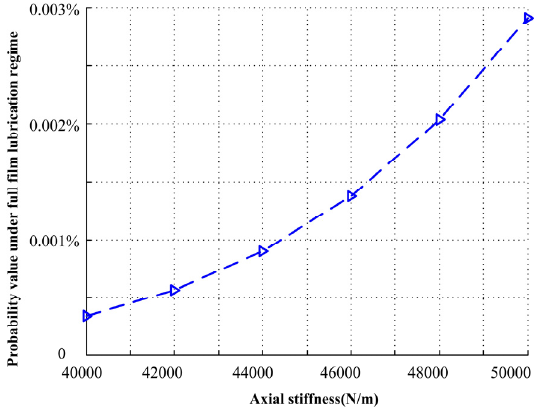
Figure 13. Probability value under different axial stiffness.